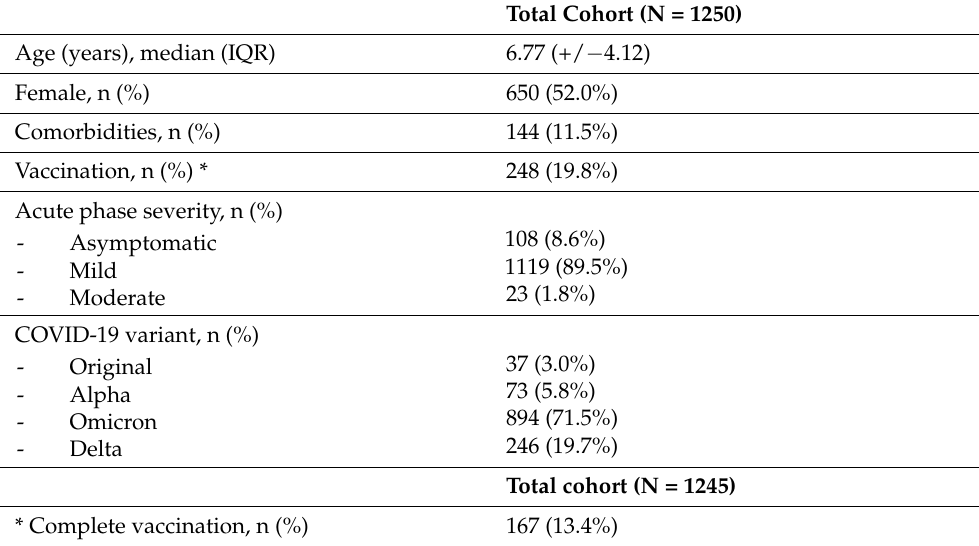
Table 1. Clinical and demographic data of the study population.